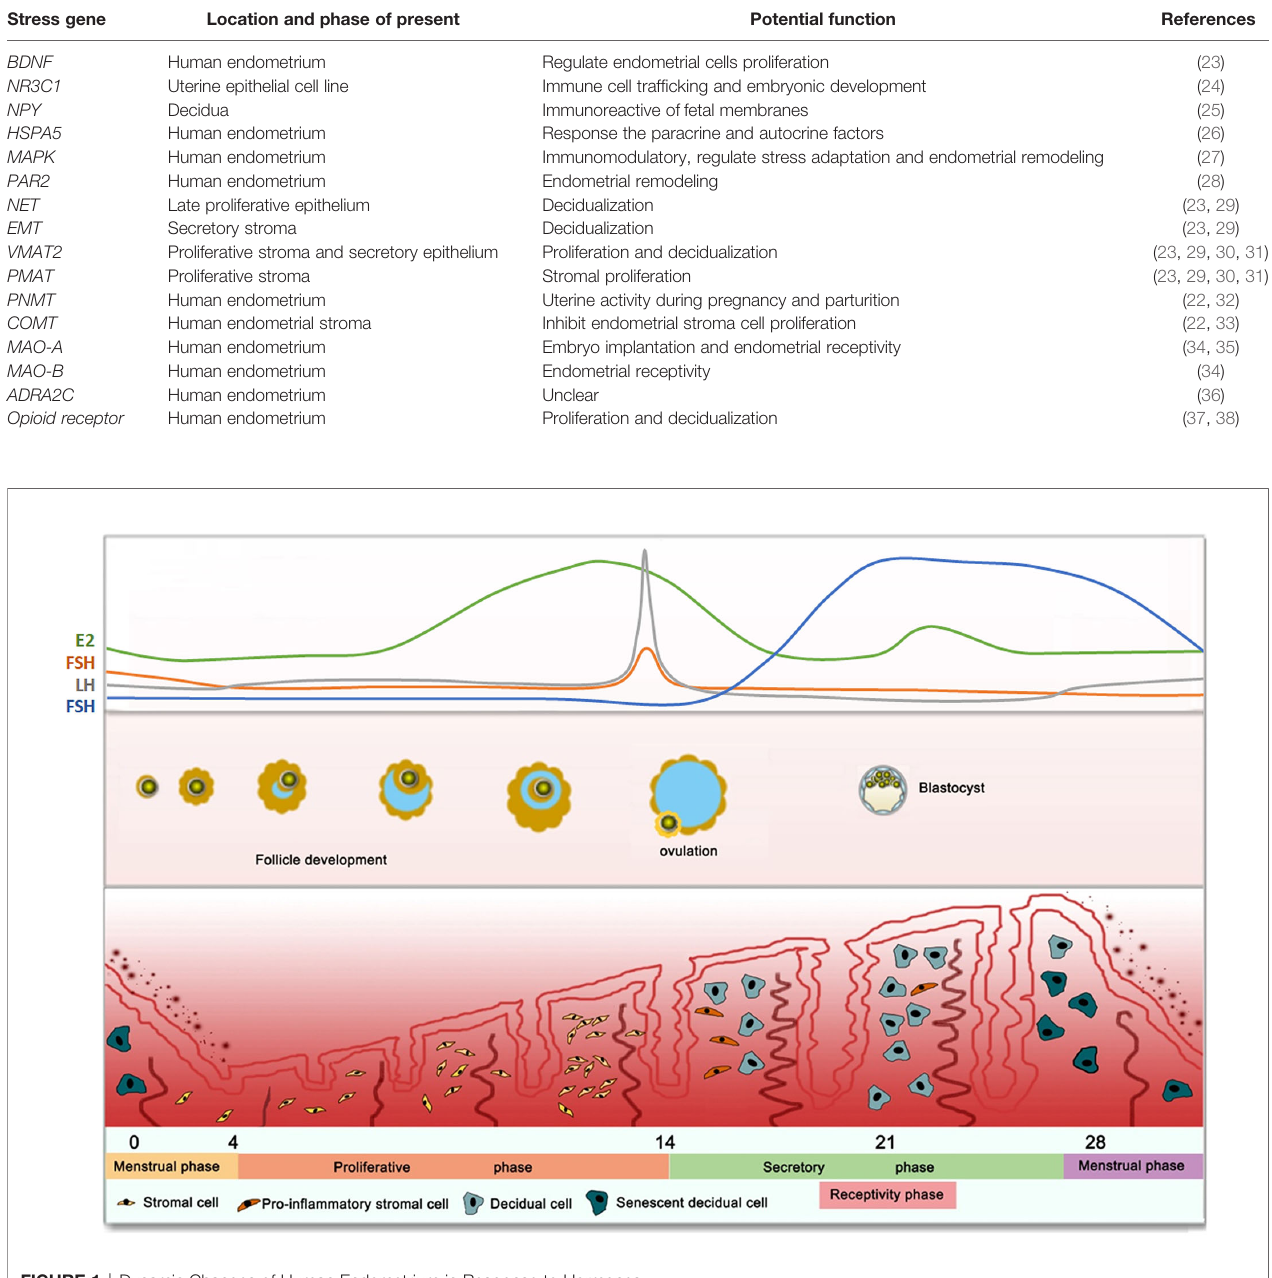
TABLE 1 | Potential stress mediators in human